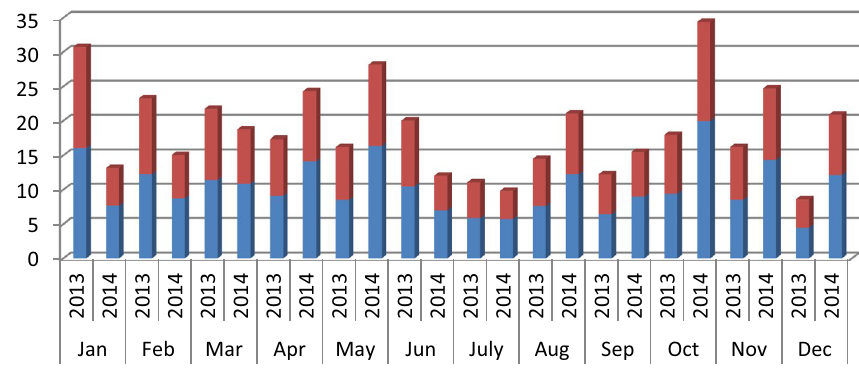
Fig. 4 Total evaporation and % contribution for water loss from the pond of each month of 2013 and